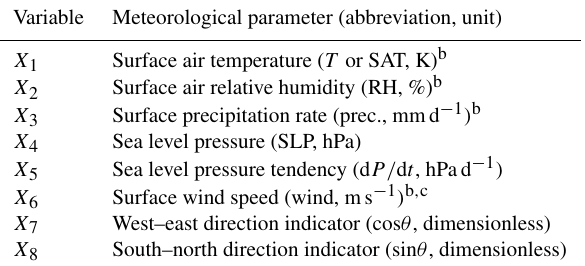
Table 1. Meteorological variables considered in this study a